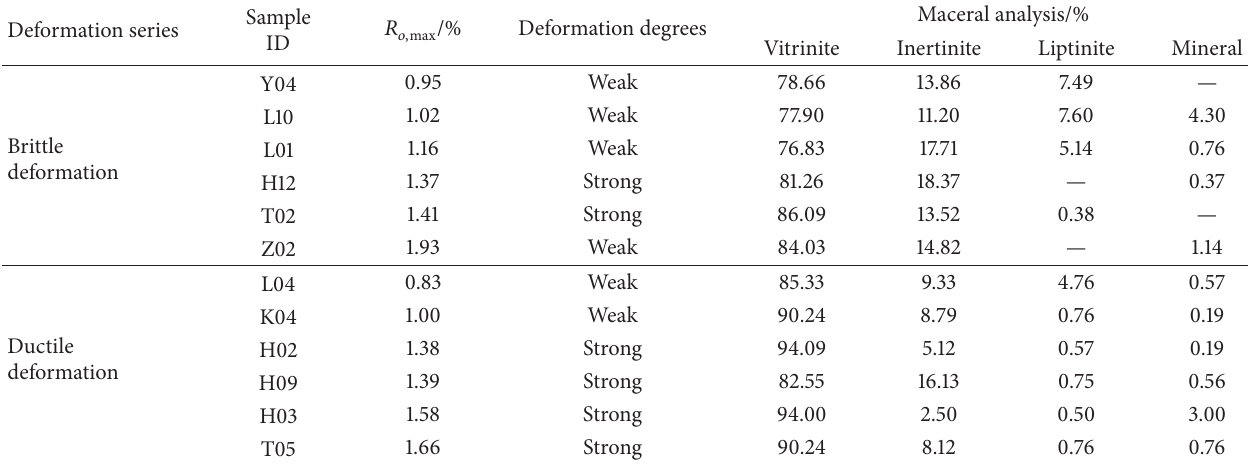
Table 2: DFT cumulative specific surface area, cumulative pore volume, and pore average width by N Deformation series